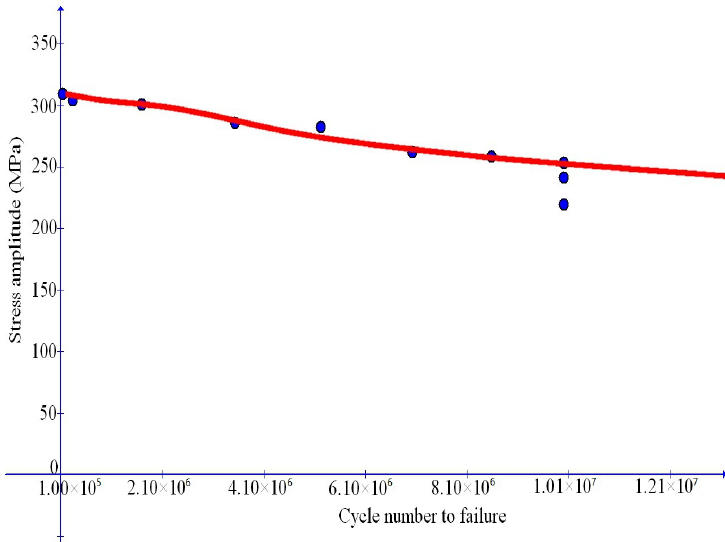
Figure 10. Comparison of simulation results with fatigue failure data (dots) from Sivananth et al. [7] for Al-matrix composite with 15% (wt) TiC reinforcing